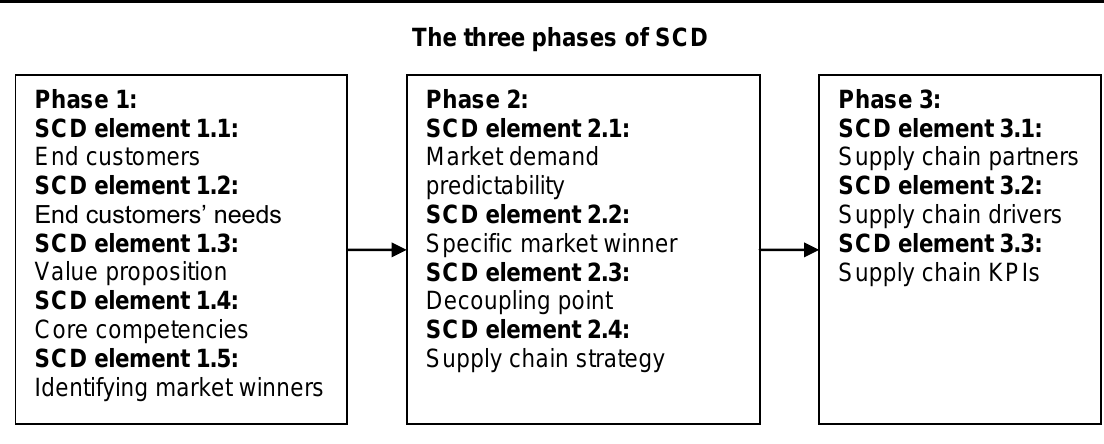
Figure 2: Summary of supply chain design